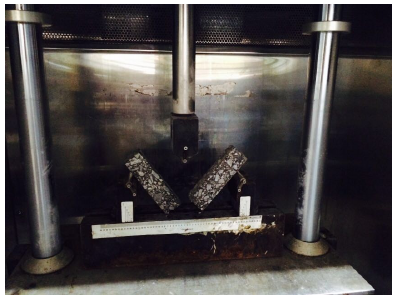
Figure 4. Three-point bending test of recycled asphalt mixture.